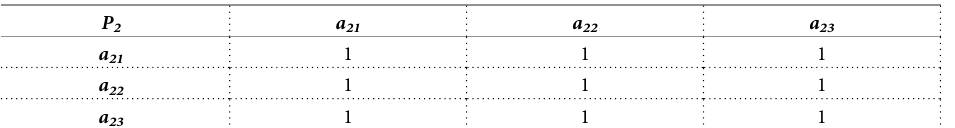
Table 7. P 2 ⬅ { a 21 , a 22 , a 23